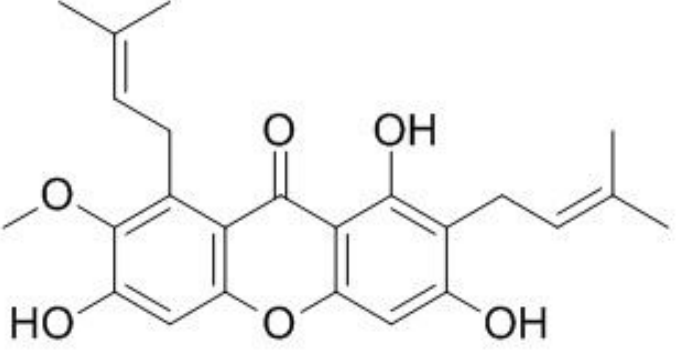
Figure 3. Chemical structure of α -mangostin.